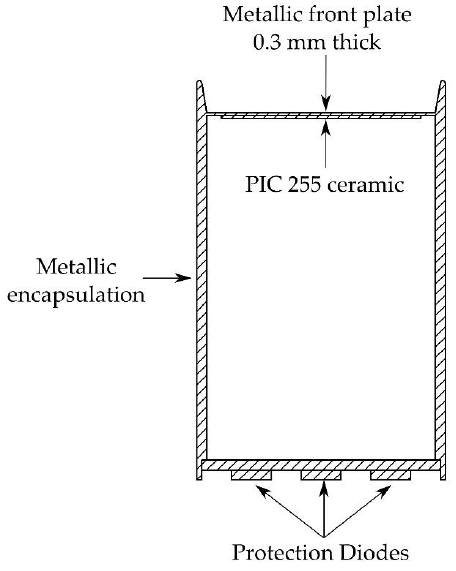
Figure 1. Design scheme of the sensor.